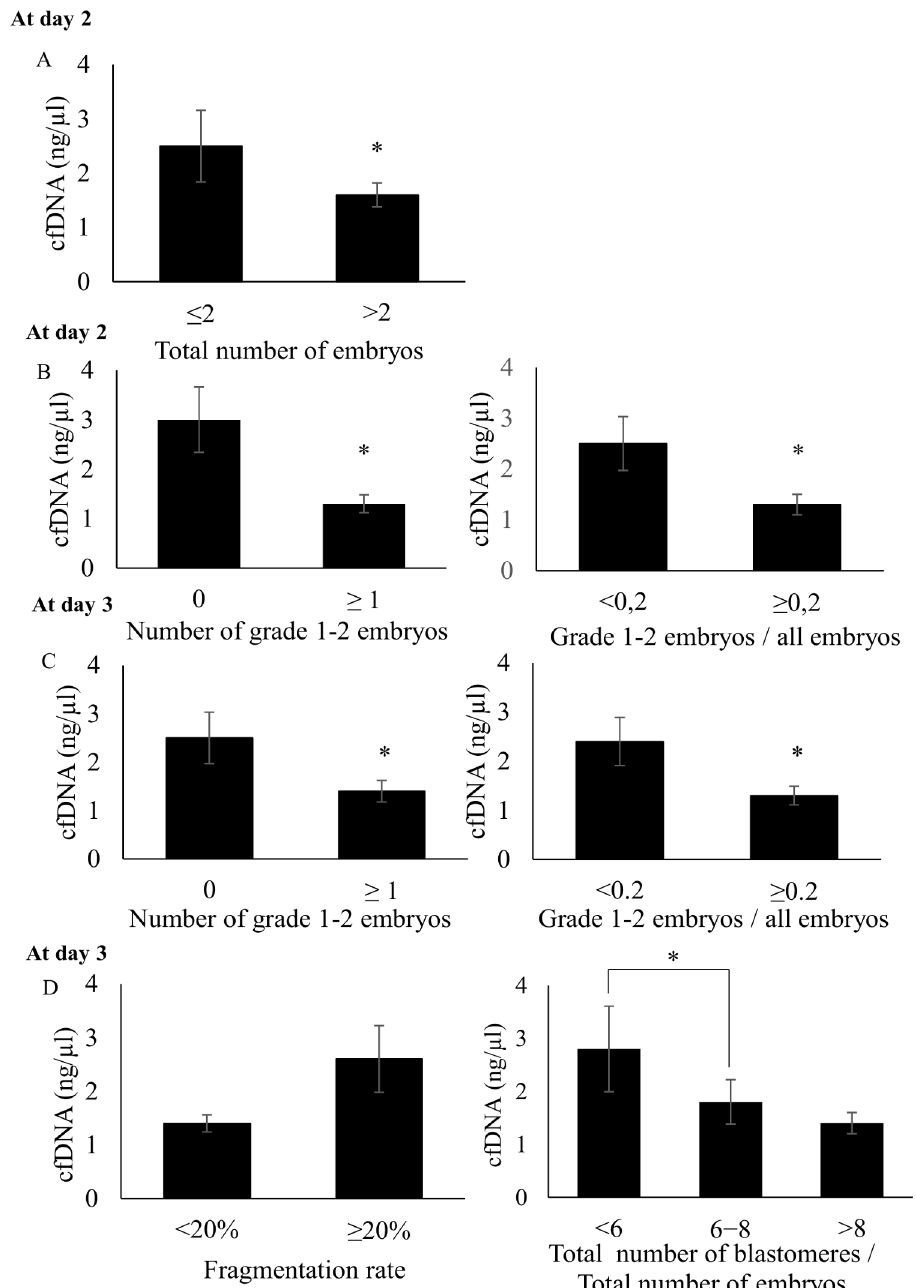
Fig 3. CfDNA level in follicular fluid pools according to the embryo outcome at day 2 and 3. A , Follicular Fluid cfDNA content according to the total number of embryos at day 2 ( (cid:3) 2 versus > 2, * p = 0.03). B , Follicular Fluid cfDNA content according to, left panel: the number of top quality (grade 1 – 2) embryos per patient (0 versus (cid:1) 1, * p = 0.002) at day 2, right panel: ratio between number of top quality embryos and total number of embryos ( < 0.2 versus (cid:1) 0.2, * p = 0.04) at day 2. C , Follicular Fluid cfDNA content according to, left panel: number of top quality (grade 1 – 2) embryos per patient (0 versus (cid:1) 1, * p = 0.006) at day 3, right panel: ratio between number of top quality embryo and total number of embryos ( < 0.2 versus (cid:1) 0.2, * p = 0.02) at day 3. D , Follicular Fluid cfDNA content according to, left panel: fragmentation rate at day 3 ( < 20% versus (cid:1) 20%, p = 0.18) and right panel: ratio between blastomere number and total embryo number at day 3 ( < 6 versus 6 – 8, * p = 0.02).